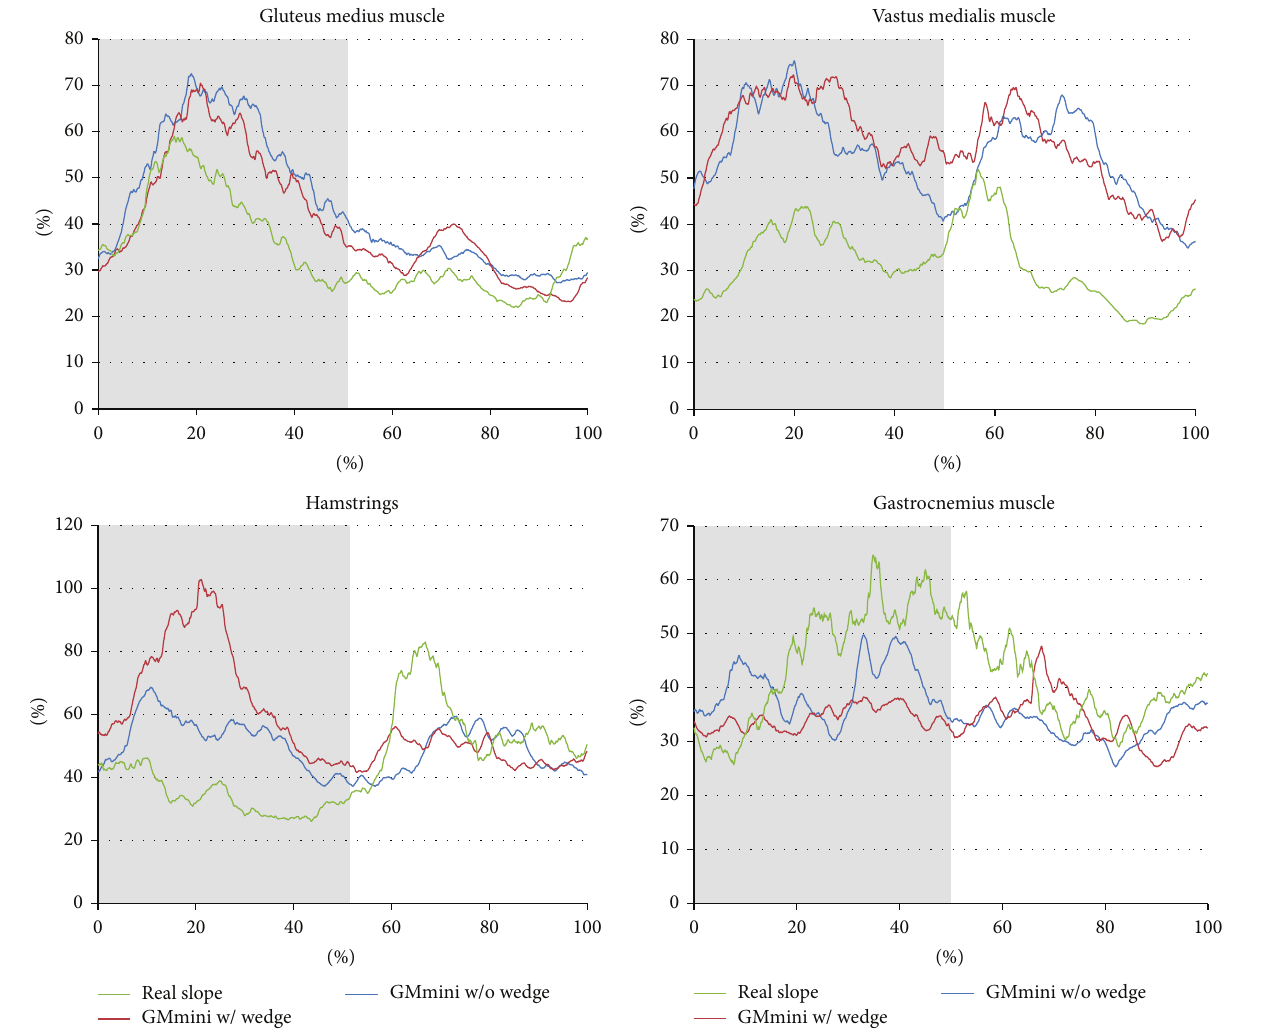
Figure 16: Time series variation of the average RMS values of the EMGs during descent a − 15-degree incline.